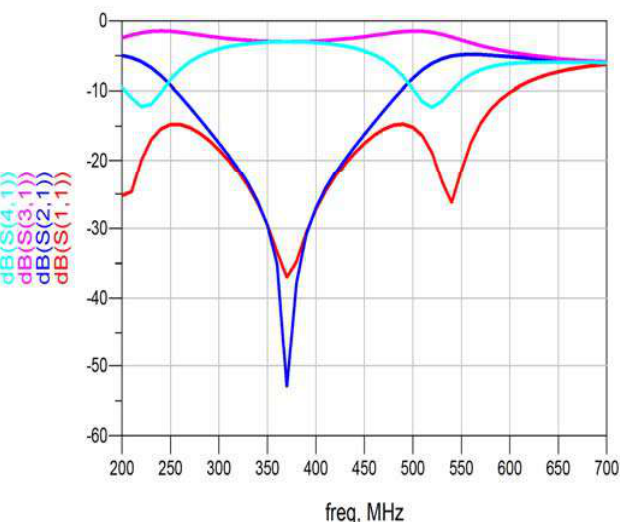
Fig .9: Simulated S- parameters of micro strip Ring Rat-Race coupler